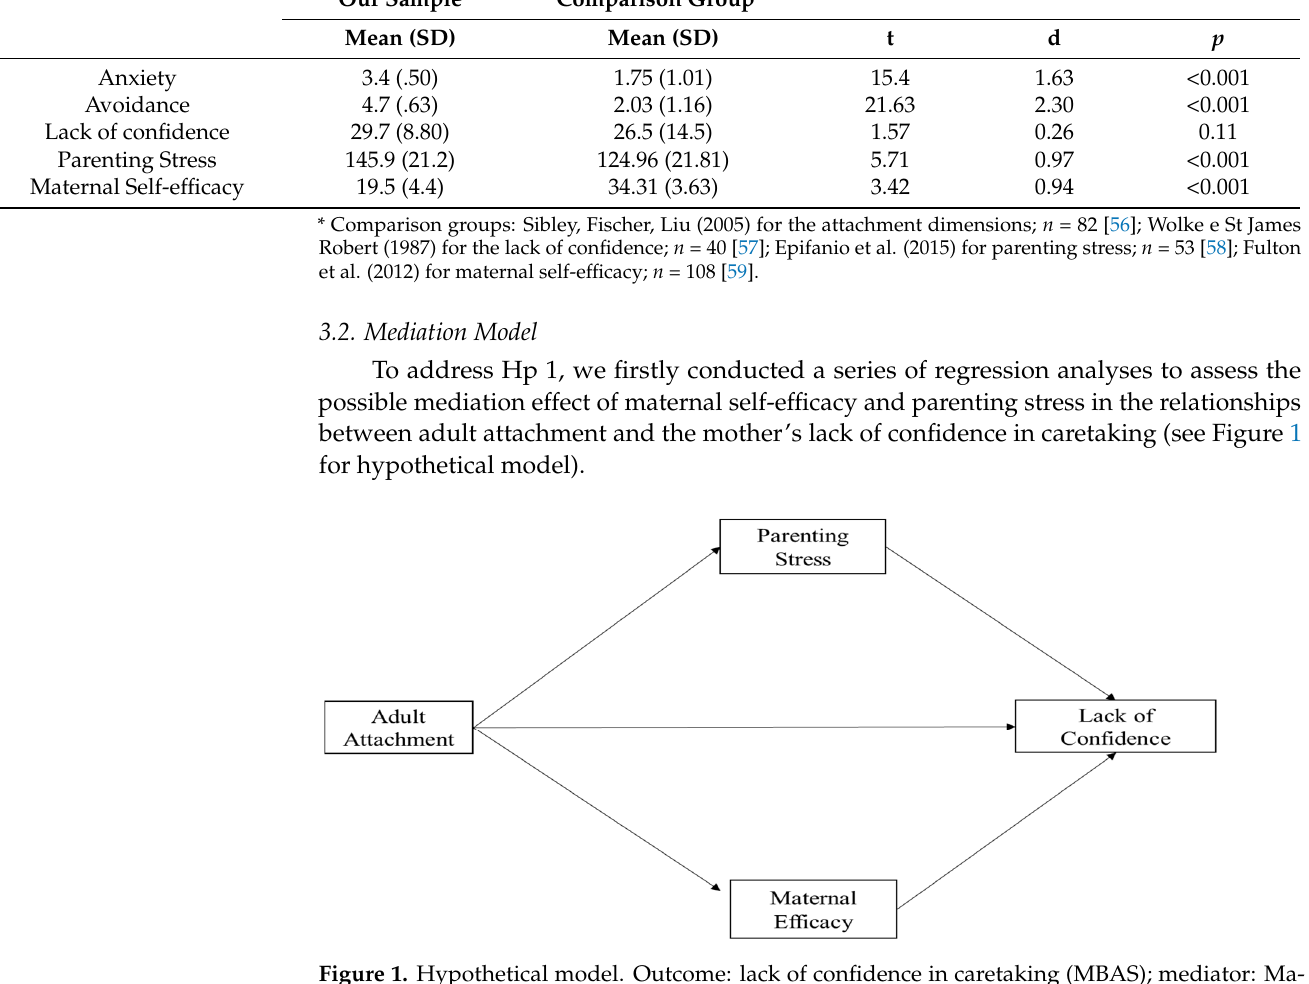
Table 2. Table of comparison.